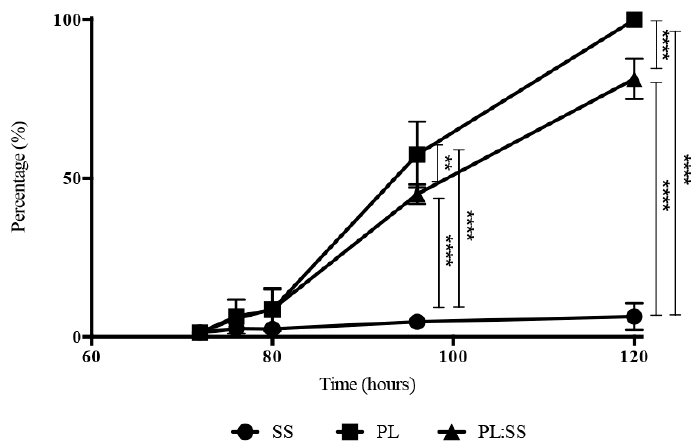
Figure 5. Evaluation of cell proliferation. Proliferation rate of synchronized growth arrested BMSC after stimulation with Sericin (SS), Platelet Lysate (PL), and PL:SS. Data are presented as percentage of the highest growth observed at 48 h in cells stimulated with PL alone. We determined growth rates of three different synchronized primary BMSC cultures in triplicate, **** p < 0.0001, ** p < 0.01. A corresponding e ff ect was observed evaluating Cyclin D1 expression by Western Blot analysis in synchronized BMSC after 8 and 24 h of PL and SS:PL treatments. The highest stimulatory e ff ect was observed at 8 h for both PL alone and PL:SS (Figure